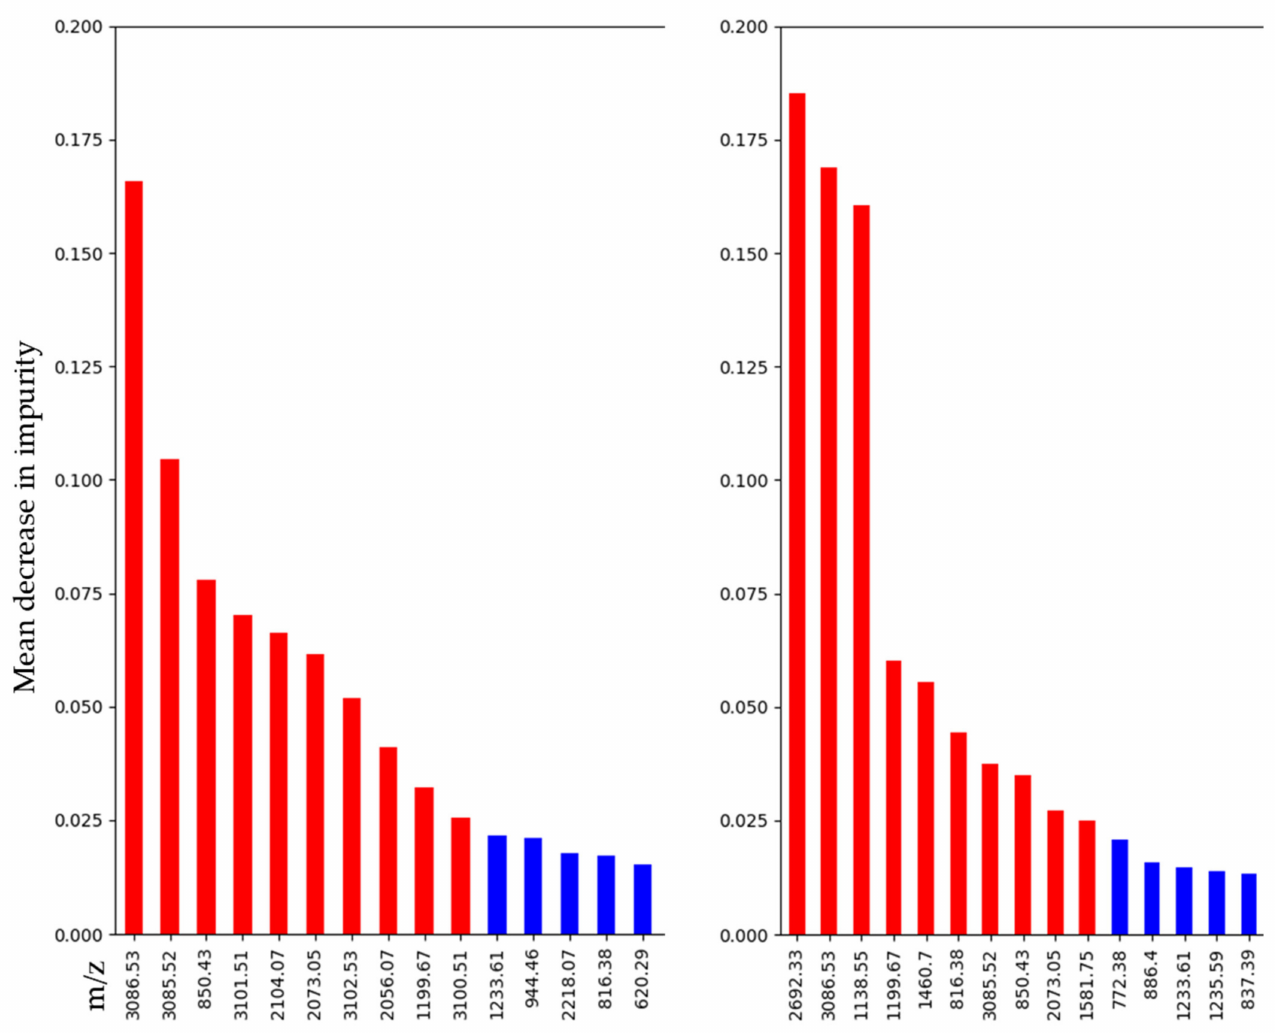
Figure 3. Feature importance using the mean decrease in the impurity of gradient-boosting classifi- cation on whole dataset (left side) and balanced dataset (right side) (top 10 features with red bars, others with blue bars). Table 4. Tentative MS/MS